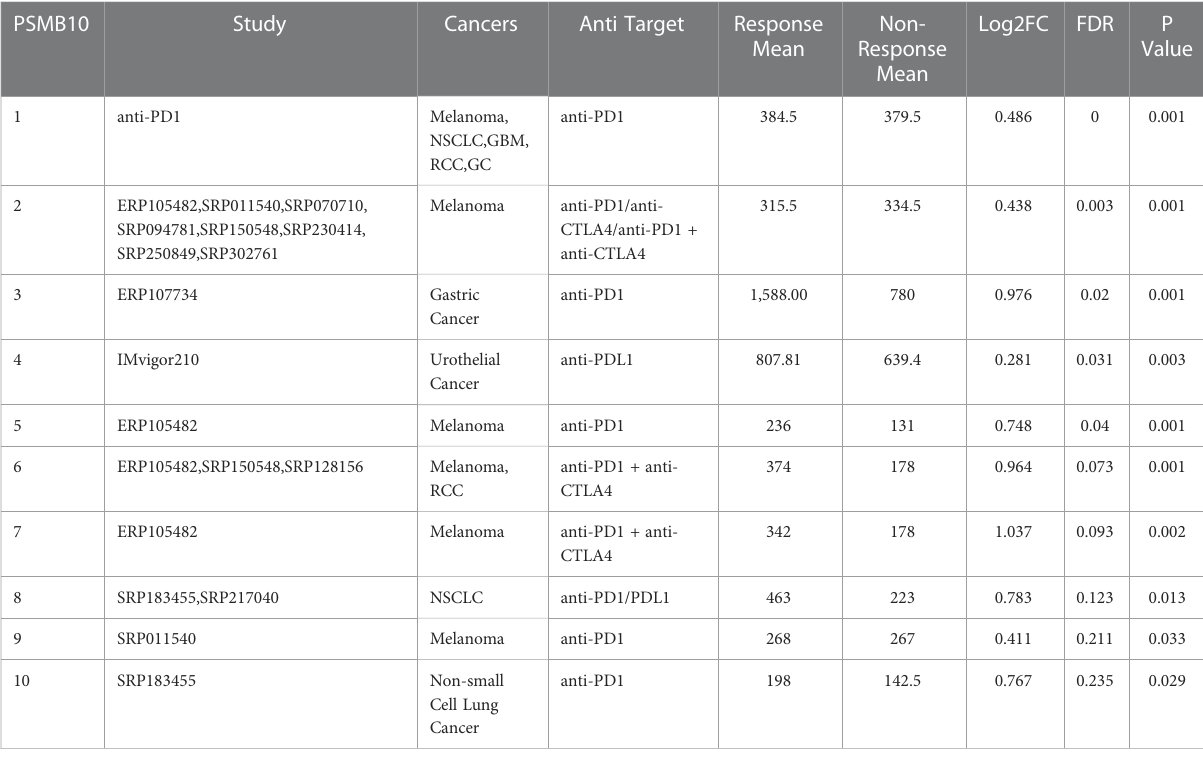
TABLE 3 PSMB10 expression distribution for response and non-response based on pre-treatment samples in all